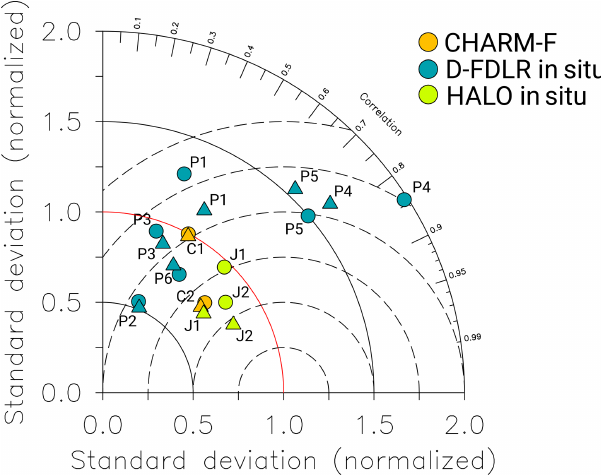
Figure 13. Taylor diagram summarizing normalized standard devi- ation (radius), correlation coefficient (angle) and centred NRMSE (dashed semicircles). Results show the comparison between obser- vations and the model domain CM7 (triangles) and CM2.8 (circles). Comparisons to C1 and C2 are displayed in orange, those to P1 until P6 in blue and those to J1 and J2 in green. P7 is outside the